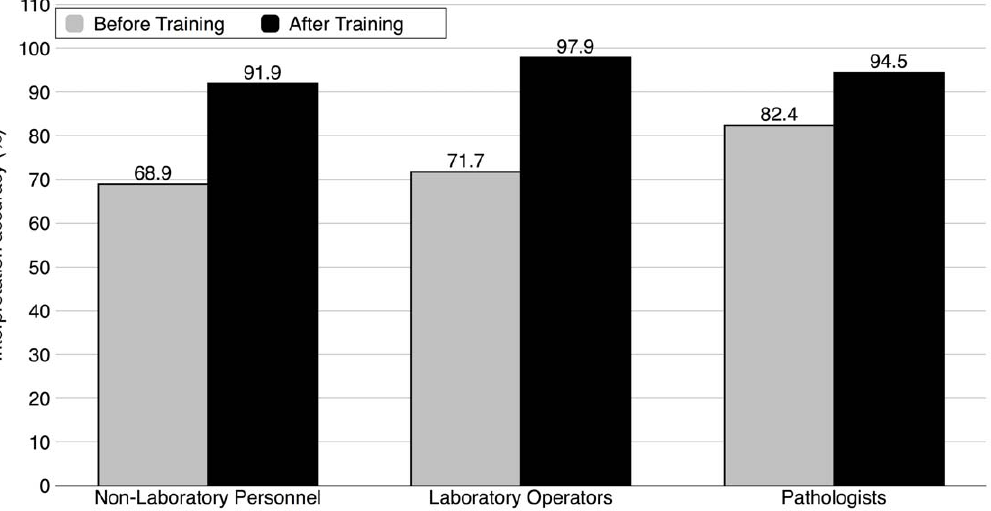
Figure 1. Overall improvement in the interpretation accuracy for the three groups of participants. Non-laboratory based personnel (n=19), laboratory based and trained technical staff (n=22) and a group of pathologists attending a national meeting (n=34) interpreted photographed results of 10 samples in four rapid diagnostic tests (RDT, see Methods Section). Each participant read 10 results for each test then was given an , 10 minute tutorial on how to read the tests accurately and each was supplied with manufacturers’ instructions. Training improved interpretation accuracy for each participant group (non-parametric Chi-Square test, p , 0.05 for all groups).